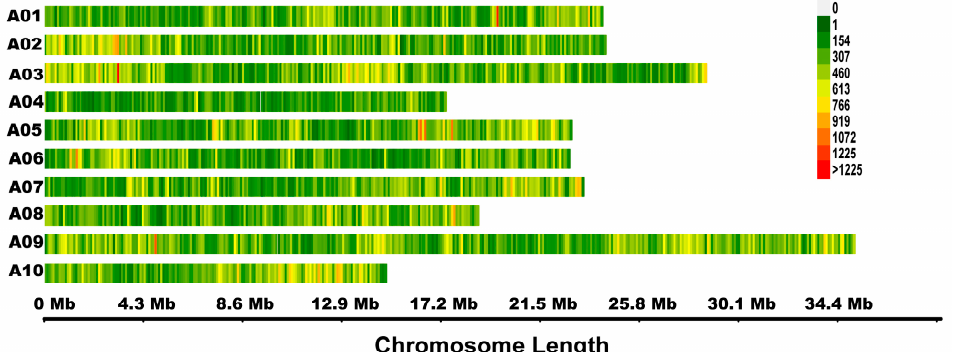
Figure 3. Distribution of 753,153 single nucleotide polymorphisms (SNPs) used in quantitative trait loci (QTL)-seq analysis. Different colors show the density of SNPs within a sliding window of 100 kb.